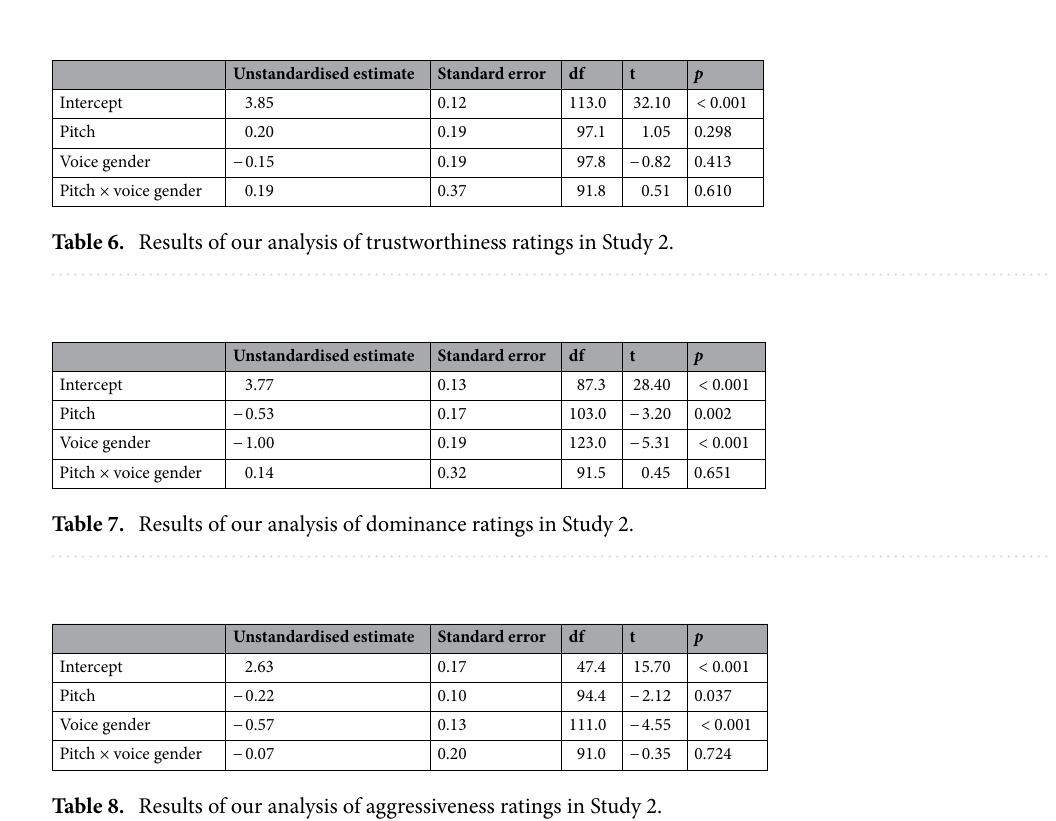
Table 5. Results of our analysis of competence ratings in Study 2.